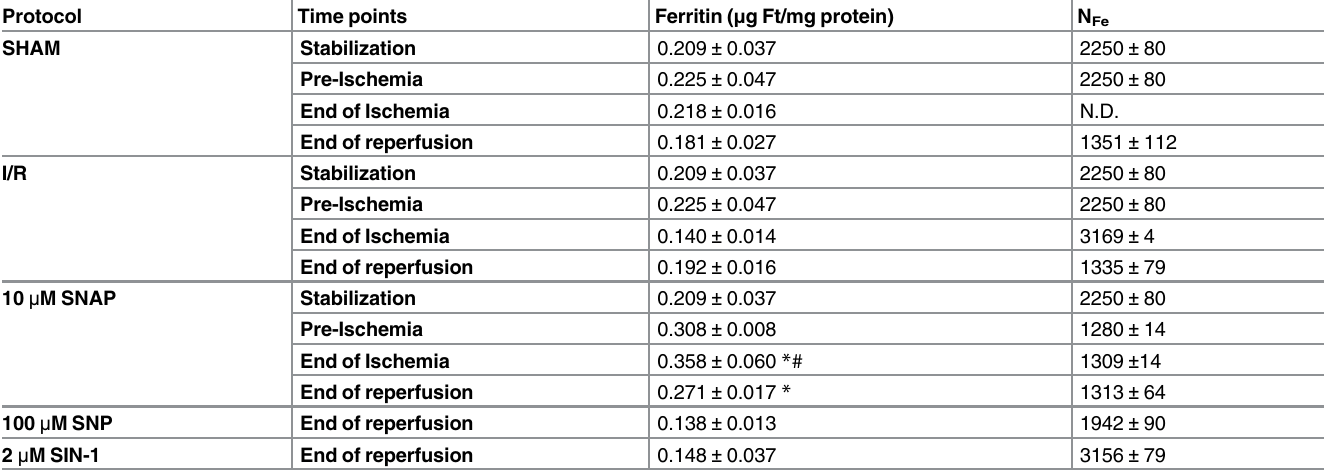
Date are presented as Mean ± SEM and indicate the heart ferritin levels and the average number of iron atoms per ferritin molecule (N Fe ), at various time points along the perfusion protocols. Complete analyses of heart Ft levels was only conducted for the I/R, SHAM and 10 μ M SNAP protocols. Iron content was determined in duplicate. Therefore no statistical analyses were conducted on the N Fe ratios for the different groups N.D.-